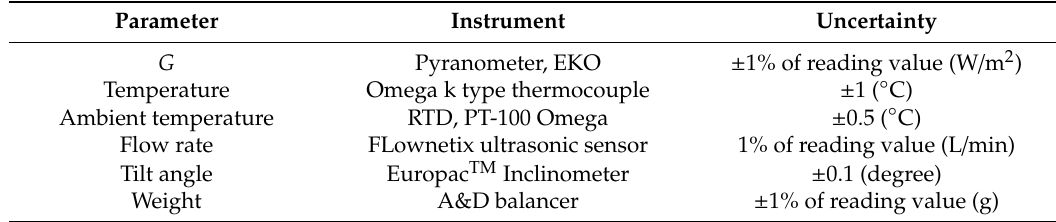
Table 1. The accuracy and uncertainty value for the apparatuses used in this work. Parameter